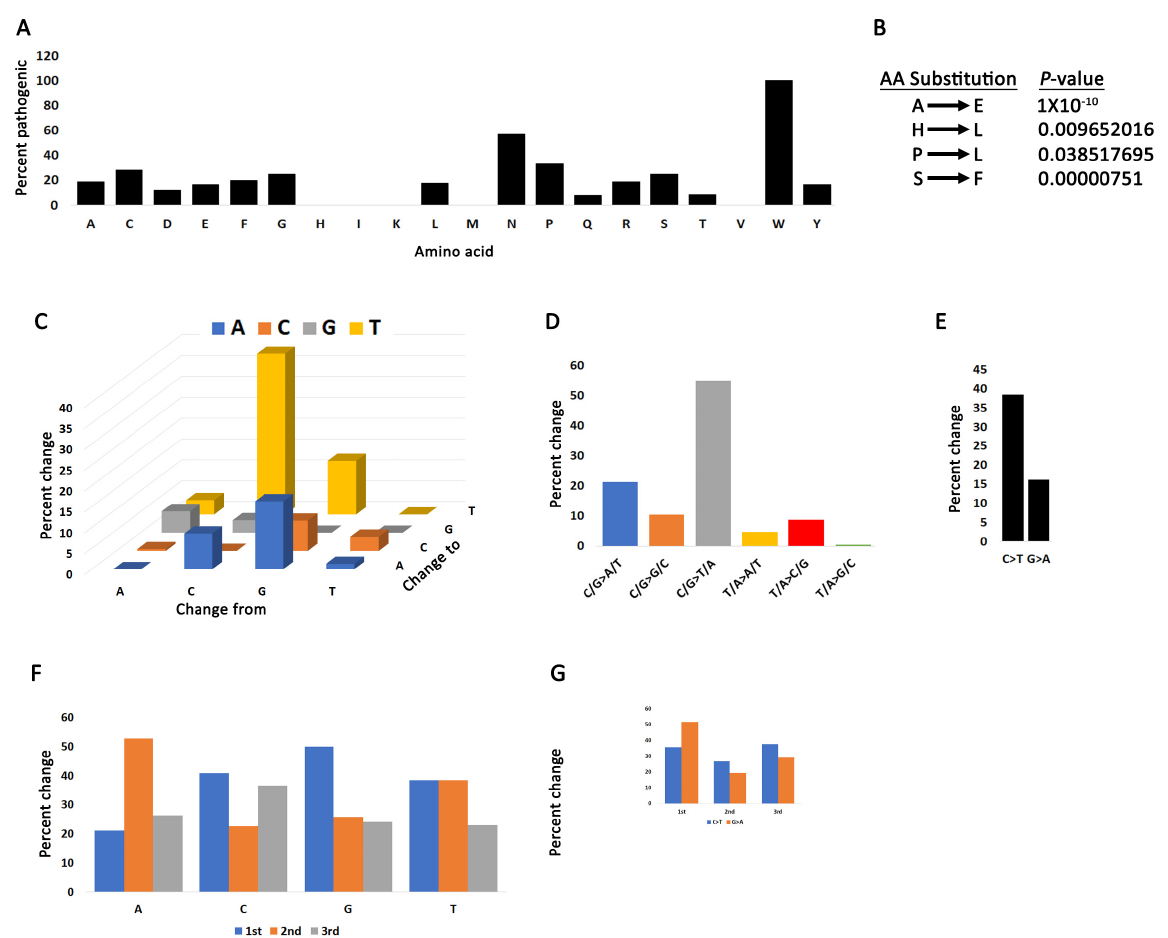
Figure 2. Mutation bias in the PRMT5 coding region. ( A ) The percent of substitutions for each amino acid that produce pathogenic mutations. ( B ) PRMT5 amino acid changes that have a statistically significant deviation from rates of change in human cancers. Chi-square test between PRMT5 and values reported by Anoosha et al. [45]. ( C ) Base pair substitutions in PRMT5. ( D ) Mutation spectrum of PRMT5 base pair substitutions in cancer cells. C/G > T/A transitions dominate the PRMT5 mutation landscape. ( E ) C > T transitions are the most prominent form of mutation. ( F ) The percent substitution of the four nucleotides occurring in the 1st, 2nd, or 3rd codon position. ( G ) C > T and G > A substitutions are more likely to occur in the first codon position.